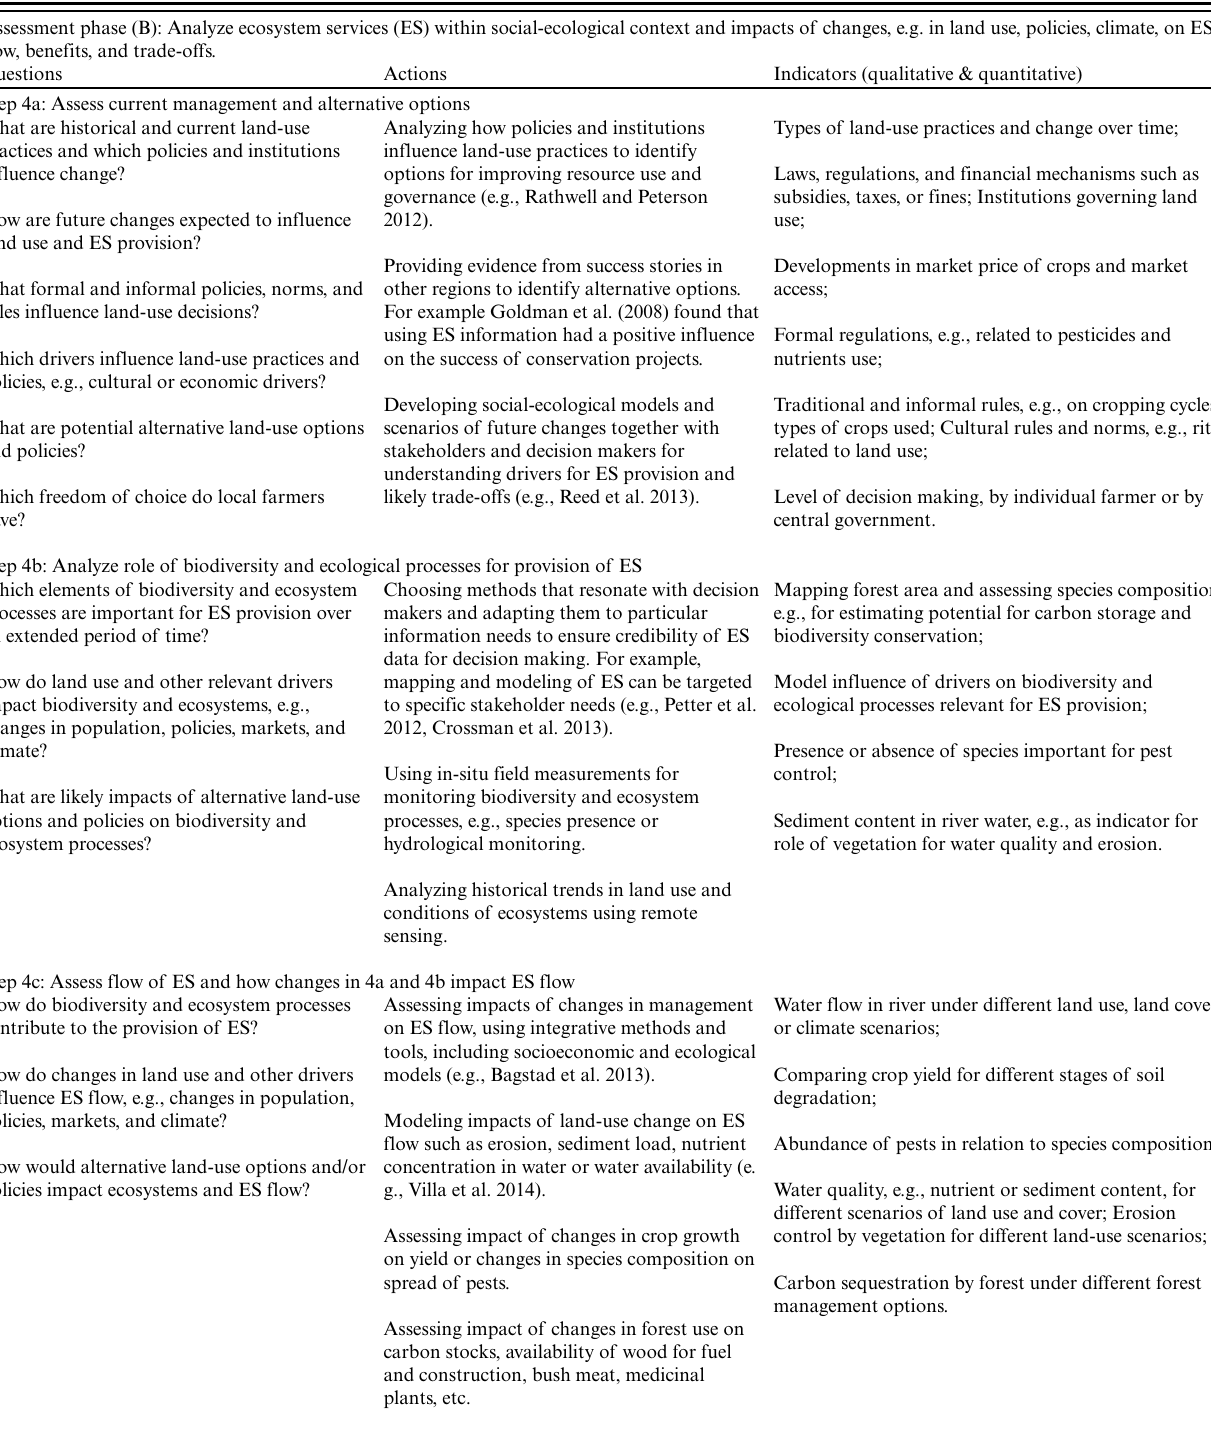
Table 2 . Examples of questions, actions, and indicators for assessment phase